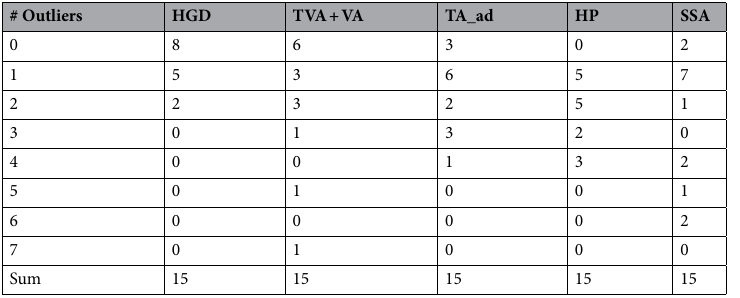
Table 2. Comparison of pathologists to self. Number of pathologists by the number of (> 2 standard deviation) outliers in relation to each pathologist’s mean call rate over the seven-year period. This tabulation shows the number of 2 SD outliers they had for each diagnosis, e.g. 8 pathologists had zero outlier years for HGD, 1 pathologist had 5 outlier years for TVA + VA (this is shown in Fig. 1H), 2 pathologists had 4 outlier years for SSA, 2 pathologists had 6 outlier years for SSA (one of the two pathologists is shown in Fig. 1G). HGD high-grade dysplasia, HP hyperplastic polyp, SSA sessile serrated adenoma, TVA+VA tubulovillous adenoma + villous adenoma, TA_ad tubular adenoma + adenoma NOS, P number of pathologists.